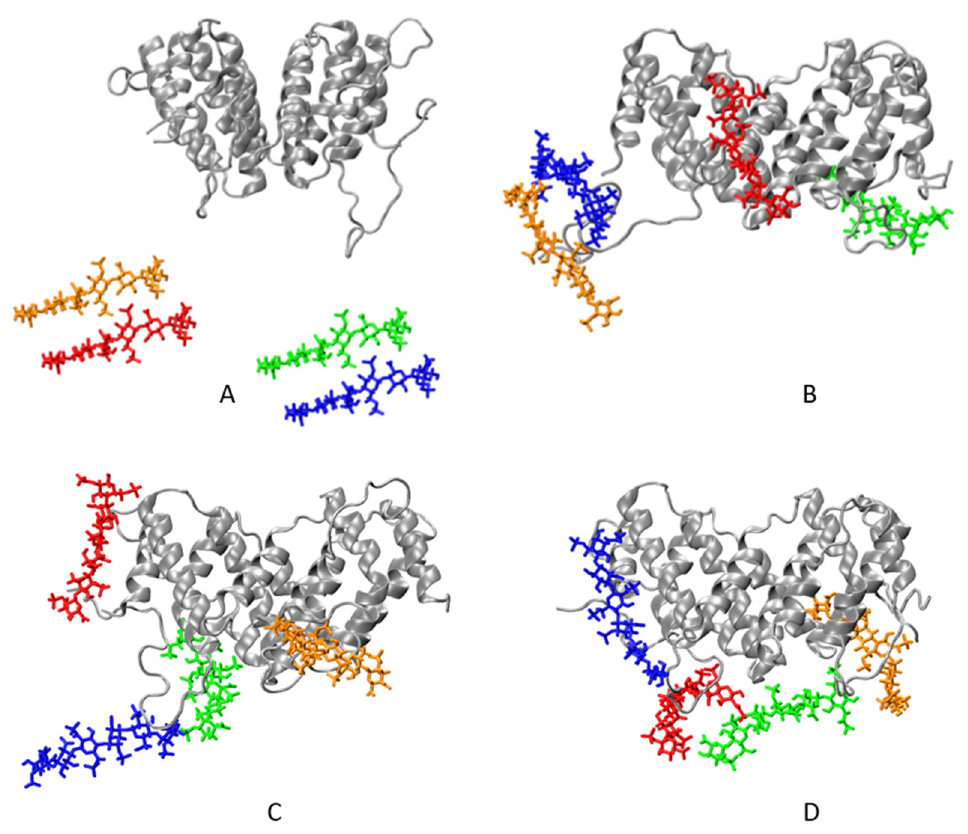
Figure 1. Initial ( A ) and final ( B – D ) configurations of the three IFN γ –LMWH hexasaccharide binding simulations. The protein is shown in gray ribbon, and the hexasaccharide chains are coloured as follows: dp6_1—green, dp6_2 –orange, dp6_3—blue, and dp6_4—red.